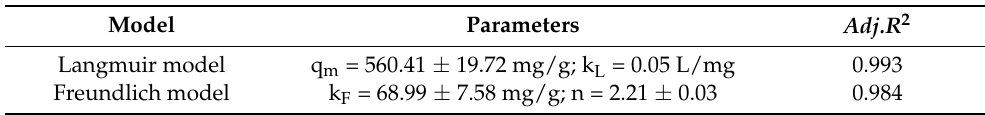
Table 3. Fitting parameters of the Langmuir and Freundlich models to the experimental data of colorant adsorption onto BBC-HAP.